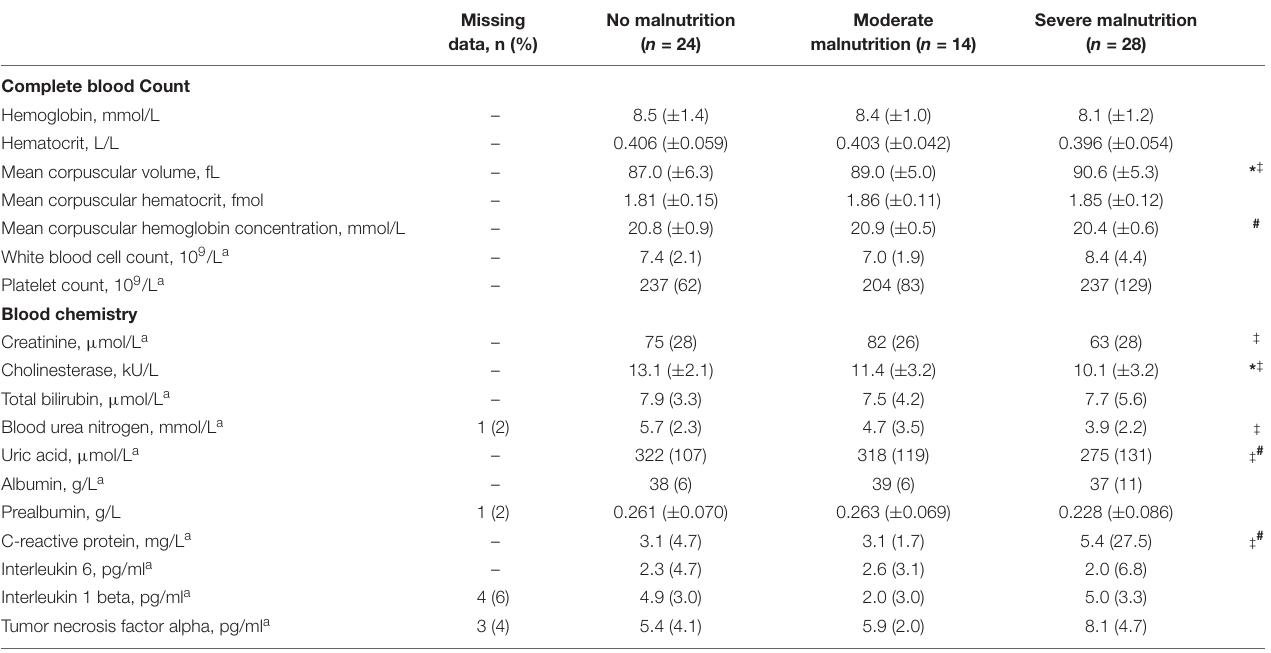
TABLE 4 | Comparison of blood parameters in patients with chronic pancreatitis stratified by nutritional